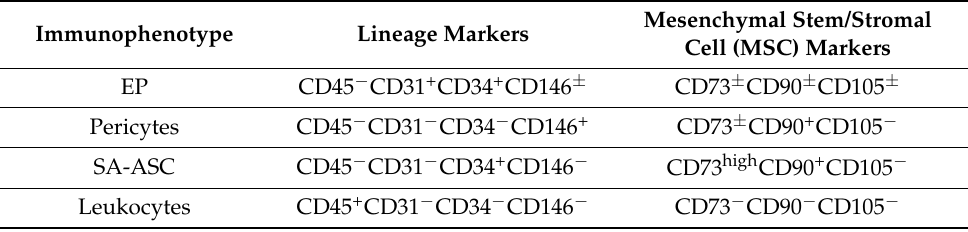
Table 1. Summarized results of the main stromal vascular fraction